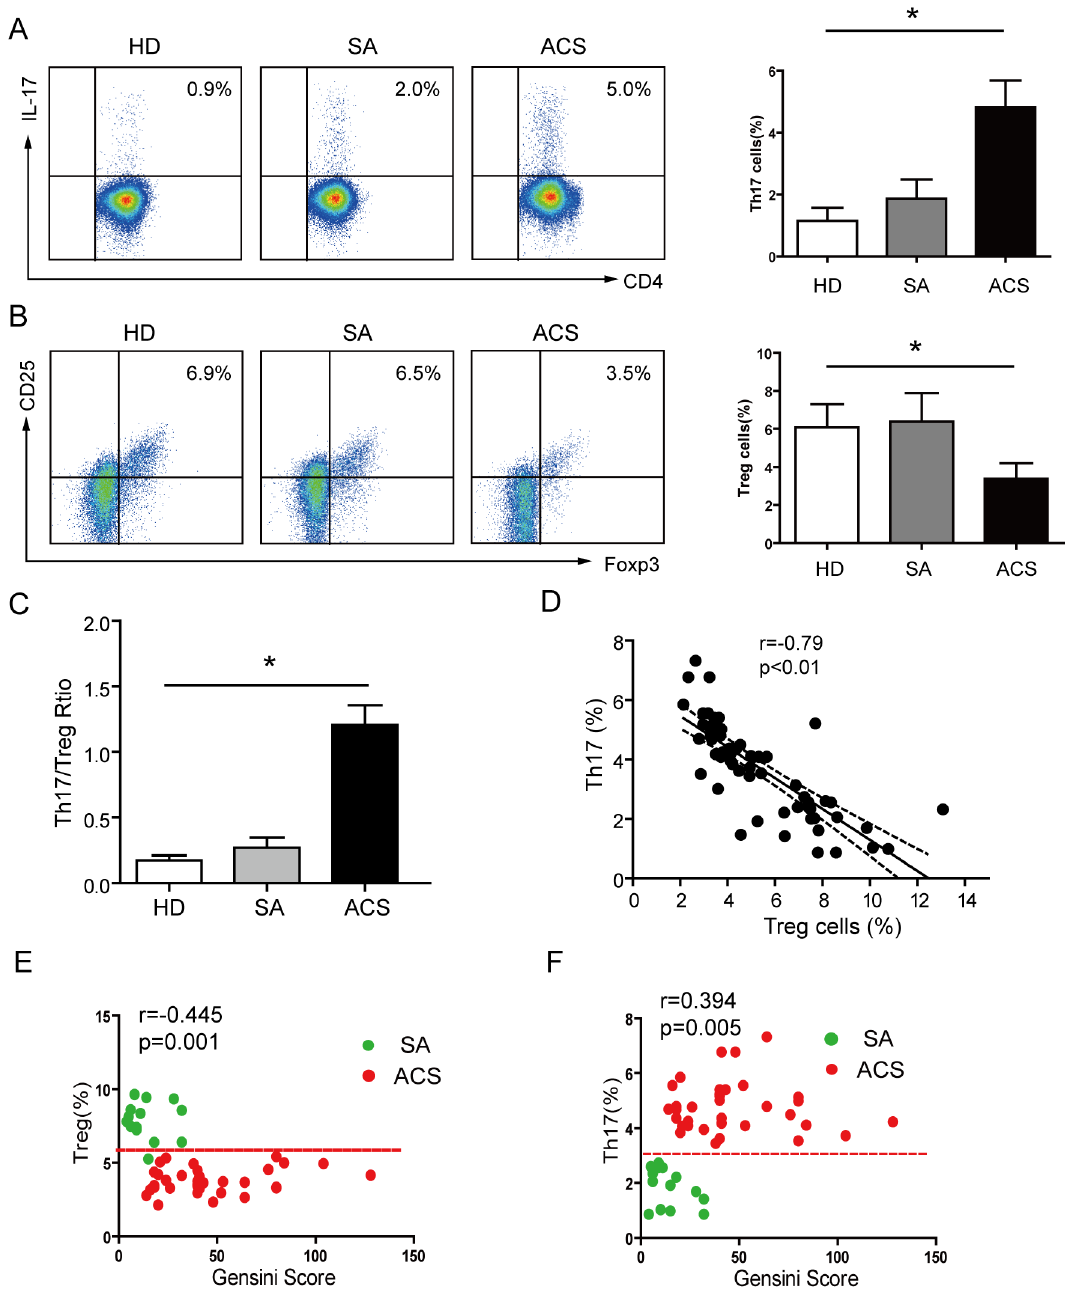
Figure 1. Imbalanced frequencies of Th17 and Treg cells in patients with ACS. (A) Representative flow cytometric (FCM) dot plots of intracellular IL-17 staining. IL-17 expression was determined by FCM gating of CD3 + CD4 + cells. A summary of the percentages of CD4 + IL-17 + T cells in different groups of patients with ACS is shown (HD, n=25; SA, n=16; ACS, n=51). (B) Representative FCM dot plots of Treg cell quantification. Treg cells are defined as CD25 + FOXP3 + double-positive cells. A summary of the percentages of Treg cells in different groups of patients with ACS is shown; p , 0.05 compared with HDs. (C) The ratio of Th17 to Treg cells was significantly increased in patients with ACS. (D) Increased frequencies of Th17 cells in ACS patients were inversely correlated with the percentages of Treg cells. Scatter plots of Th17 frequencies and Treg frequencies with the Gensini Score. (E) A significant positive correlation between Th17 and the Gensini score was identified. (F) Treg cell frequencies negatively correlate with the Gensini score. Pearson’s correlation coefficient (normal distributed data) and Spearman’s rank correlation coefficient (non-normal data) were used to assess interrelationships. *: P , 0.05 is considered statistically significant. doi:10.1371/journal.pone.0072804.g001 frequencies of Th17 cells negatively correlated with that of Treg both HD and SA groups, whereas higher frequencies of Th17 cells with lower frequencies of Tregs resulted in enhanced Th17/Treg cells in individual with ACS (r = 2 0.79, P , 0.05) (Fig. 1D). ratios in the ACS groups ( P , 0.01). Accordingly, increased To investigate whether upregulated Th17 and deregulated Treg levels related to the severity of CAD, a bivariate correlation